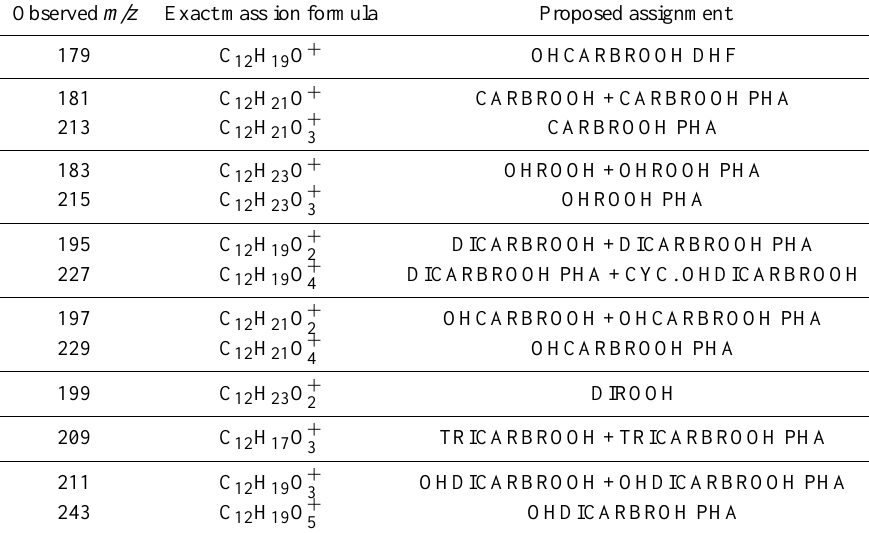
Table 6. Selected ions monitored by the AMS in the hexylcyclohexane system. Observed